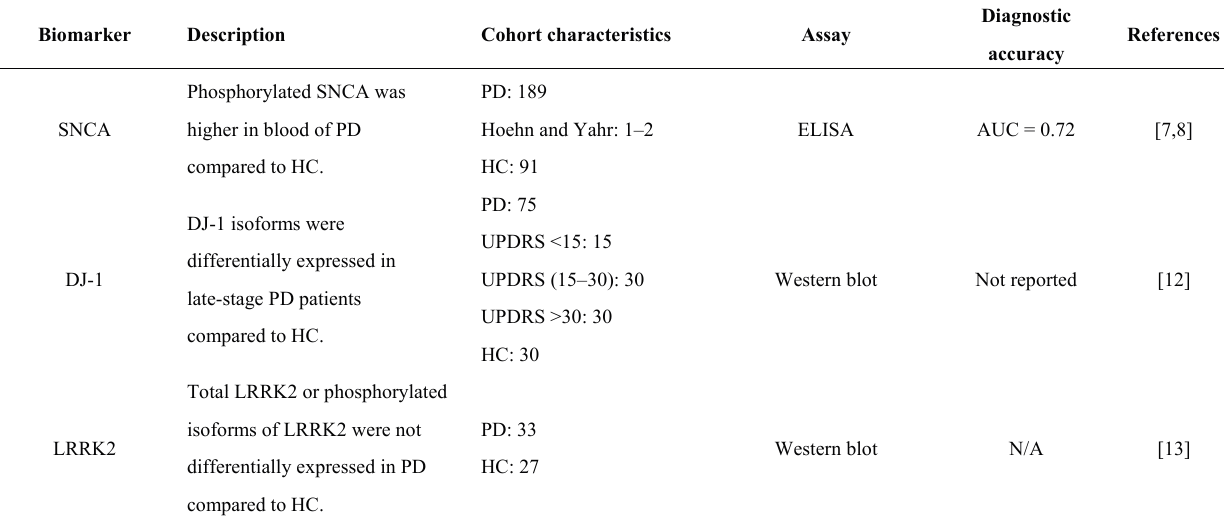
Table 1. Candidate protein biomarkers in the blood of PD patients. The number of participants and the PD rating of the patients using the Hoehn and Yahr scale or the Unified Parkinson’s Disease Rating Scale (UPDRS) is provided under cohort characteristics. PD is Parkinson’s disease; HC is healthy control; AD is Alzheimer’s disease. N/A is not available because the results were not significant; AUC is area under the